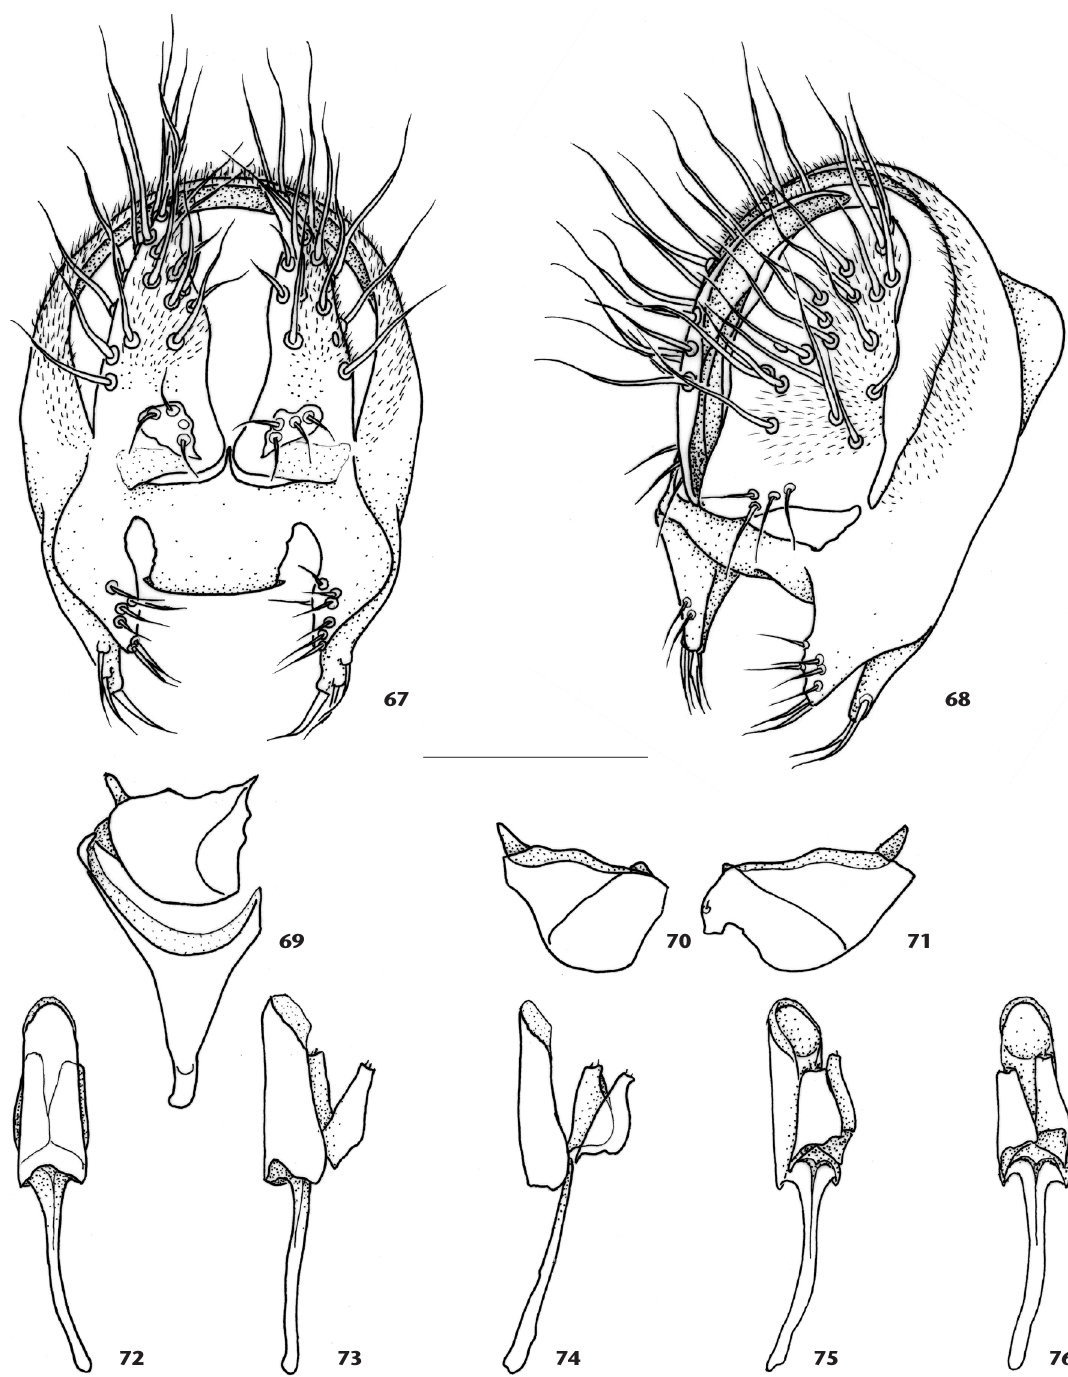
13Figures 67-76. Scaptomyza pipinna sp. nov. male holotype, terminalia: (67) epandrium, cerci, surstyli and decasternum, posterior view; (68) idem, oblique posterior view; (69) left side of hypandrium and left gonopod (right side of hypandrium accidentally broken and right gonopod accidentally detached), posterior view; (70) left gonopod, posterior view; (71) right gonopod, posterior view; (72-76) aedea- gus+aedeagal apodeme, and paraphyses, several views from dorsal through ventral. Scale bar: 0.1 ZOOLOGIA 33(6): e20160142 | DOI: 10.1590/S1984-4689zool-20160142 | December 15, 2016 11 /